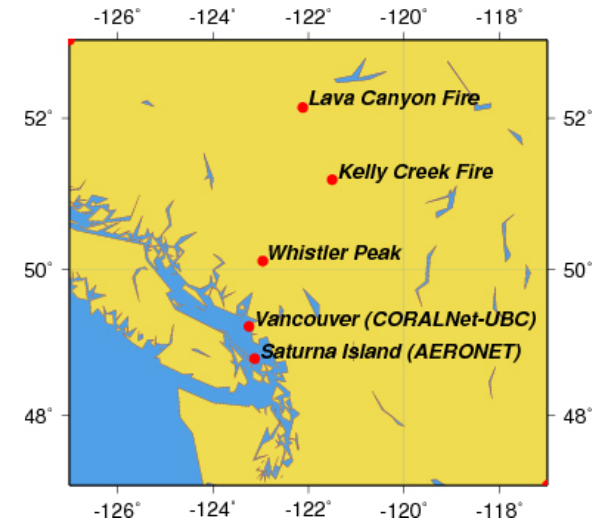
Fig. 1. Map showing places mentioned in the